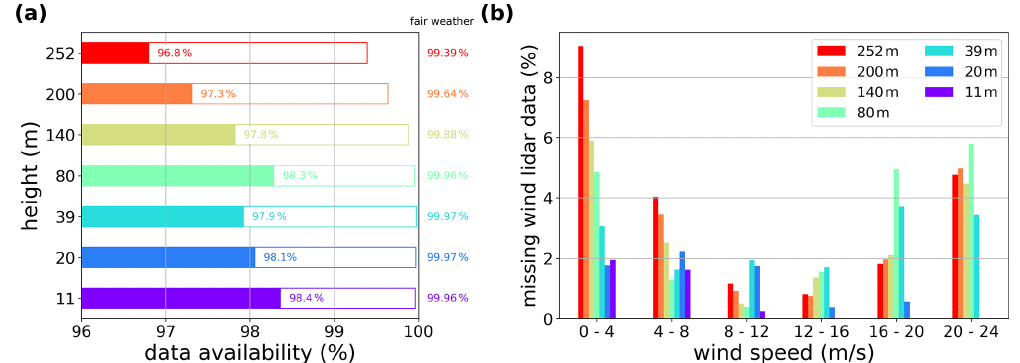
Figure 5. (a) Overall availability of QC wind lidar data for different vertical levels during the full uptime of the instrument (closed bars) and for “fair weather” conditions (open bars). (b) Percentage of missing wind lidar data for different wind speed classes based on the mast measurements at the corresponding levels. For the 252m wind lidar level, mast wind speed measurements at 200m are taken.